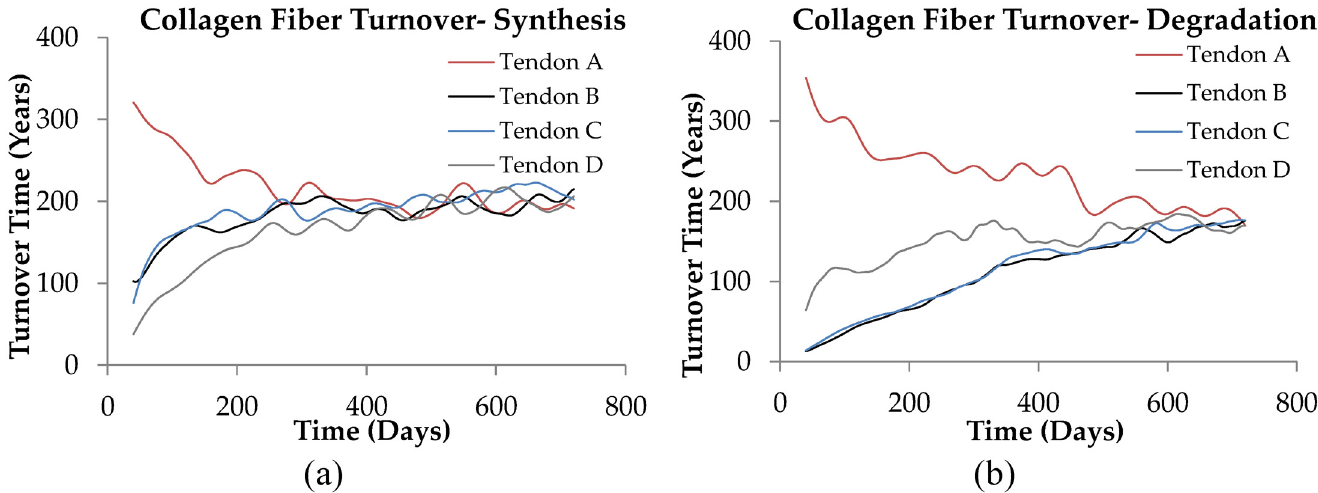
Fig 11. Collagen fiber turnover time during tendon remodeling. (a) Collagen fiber synthesis turnover time and (b) degradation turnover time for selected tendons of (Fig 10A – 10D) during the remodeling process. Collagen fiber turnover time at equilibrium reaches around 180 years.